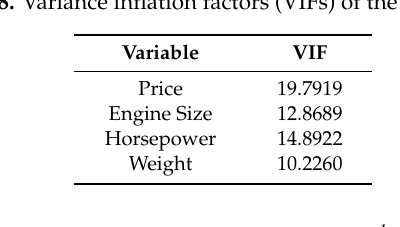
Table 8. Variance inflation factors (VIFs) of the